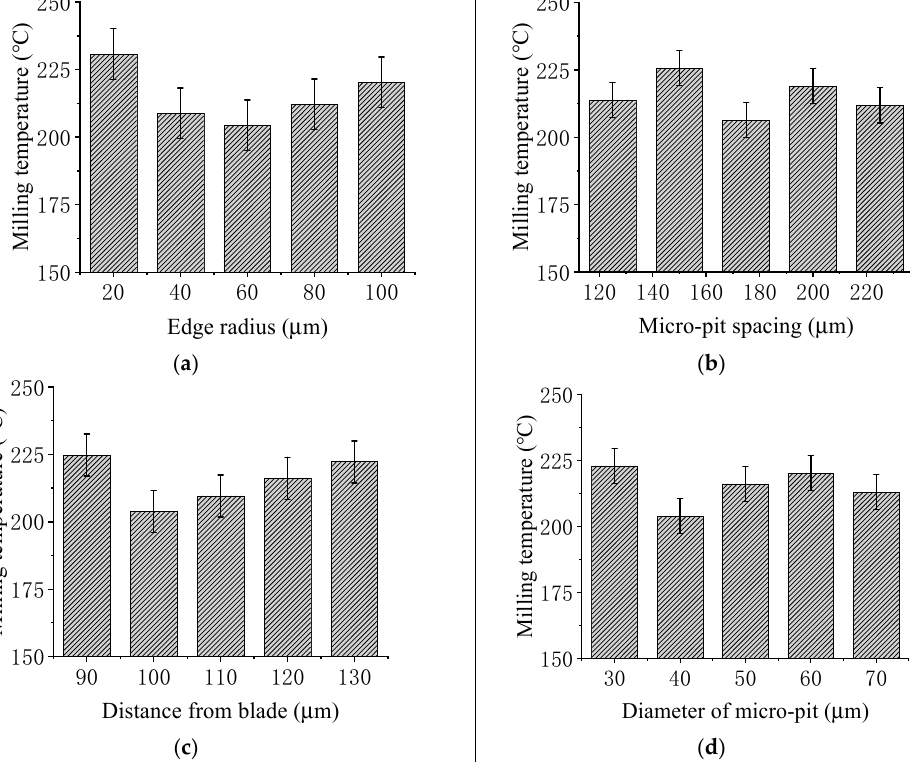
Figure 5. Influence of micro-texture parameters and blunt edge parameters on the milling temperature. ( a ) Influence of the cutting edge radius on the milling temperature. ( b ) Influence of the distance from the edge on the milling temperature. ( c ) Influence of the micro-pit spacing on the milling temperature. ( d ) Influence of the micro-pit diameter on the milling temperature. Table 4. Variance analysis of simulation